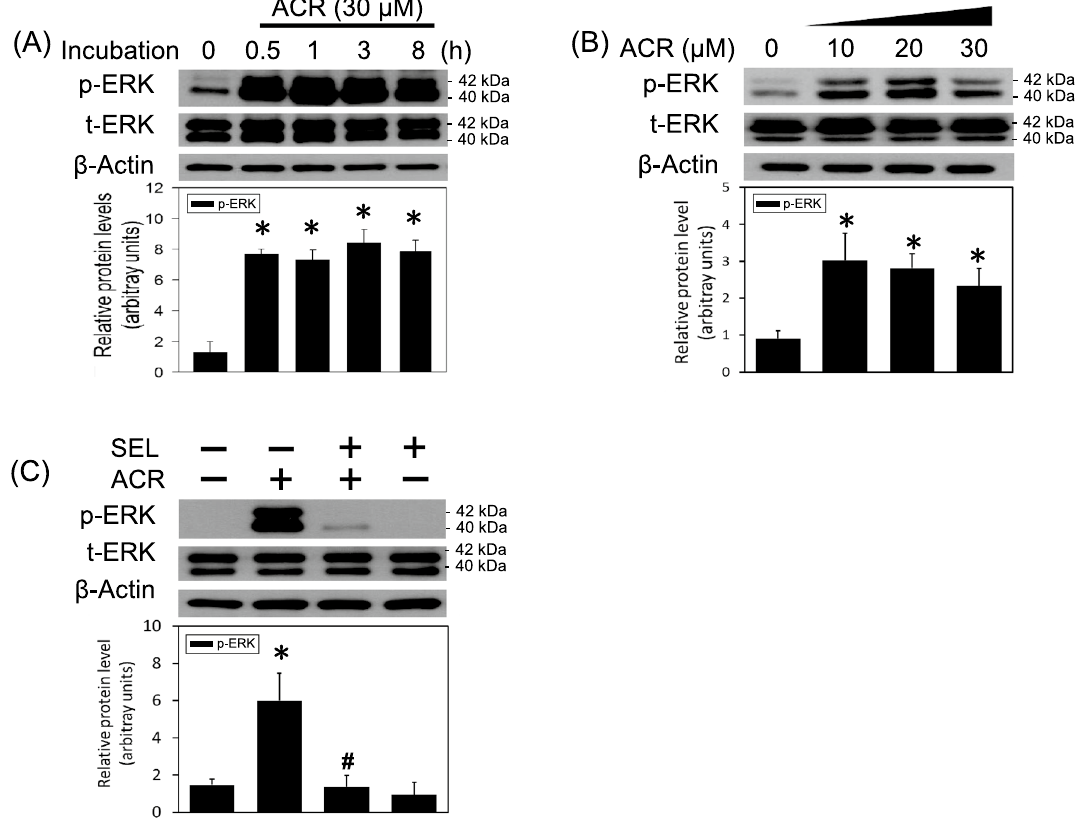
Figure 1. Effect of selumetinib on acrolein-elevated ERK phosphorylation. ( A ) Primary cultured cortical neurons were treated with acrolein (30 μM) for 0.5–8 h. ( B ) Primary cultured cortical neurons were treated with acrolein (0–30 μM) for 24 h. ( C ) Primary cultured cortical neurons were treated with acrolein (30 μM) with/ without selumetinib (SEL, 10 μM) for 24 h. Western blot assay was employed to measure total ERK (t-ERK) and phosphorylated ERK (p-ERK). Each lane contained 30 μg protein for all experiments. Graphs show statistical results from relative optical density of bands on the blots. Values are the mean ± SEM. (n = 3/treatment). *p < 0.05 statistically significant in the acrolein groups compared with the control groups; # p < 0.05 statistically significant in acrolein plus SEL group compared with acrolein group by one-way analysis of variance (one-way ANOVA) and followed by the LSD test as post-hoc method. The original Western Blot films of Figures 1 to 6 can be found in the Supplementary